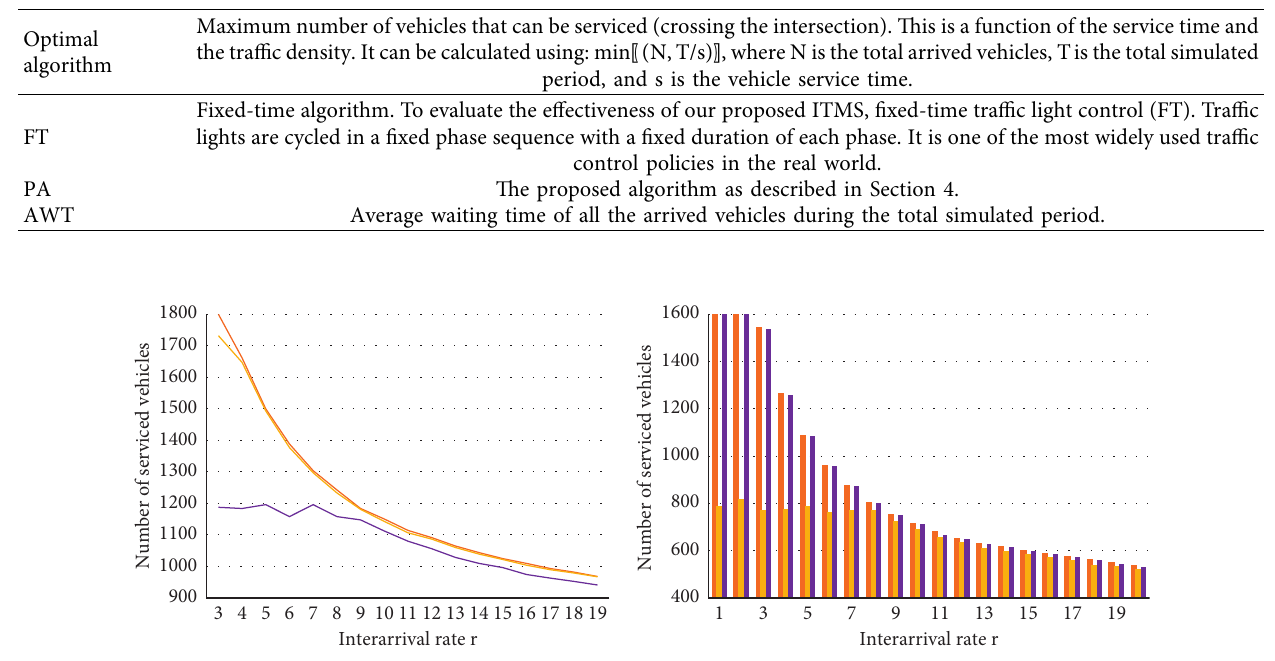
Table 4: Abbreviations in the figures.